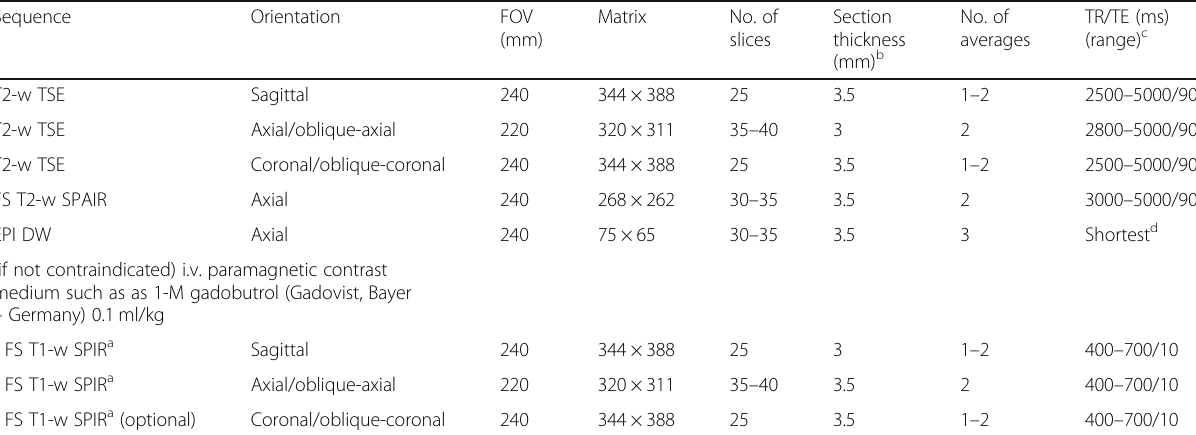
Table 3 Focused MRI acquisition protocol for the study of the ano-perineal region